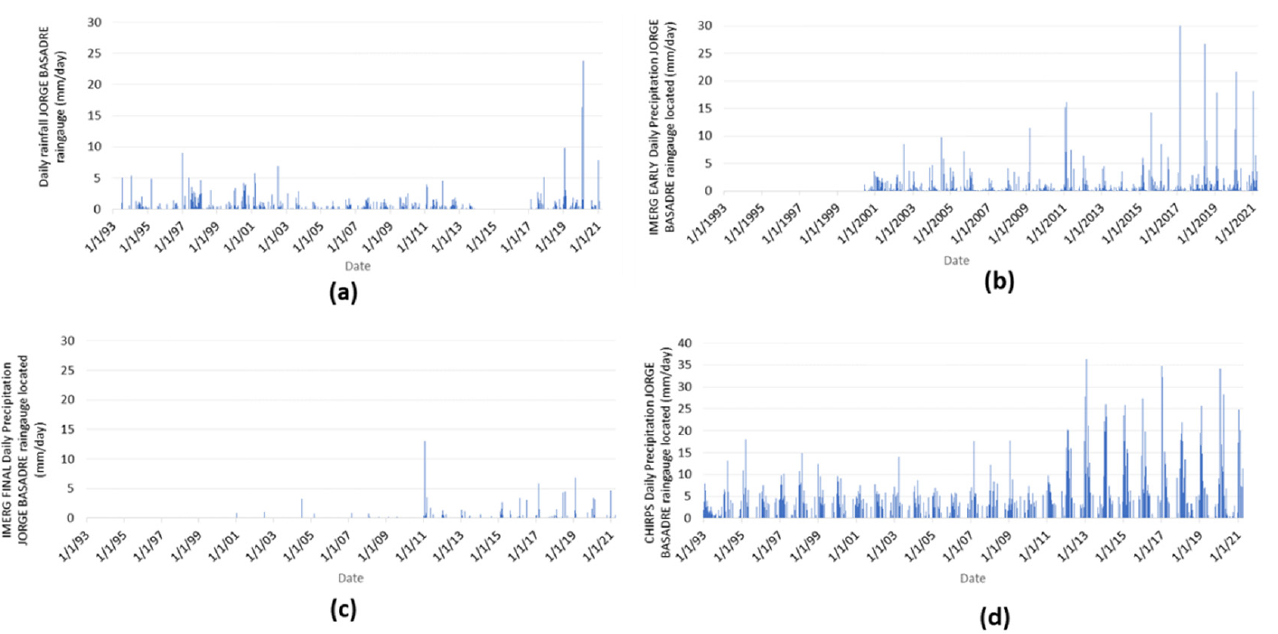
Figure 8. Comparation between ( a ) daily rainfall in JORGE BASADRE rain gauge and daily precipi- tation from satellites products: ( b ) IMERG Early, ( c ) IMERG Final, and ( d ) CHIRPS.